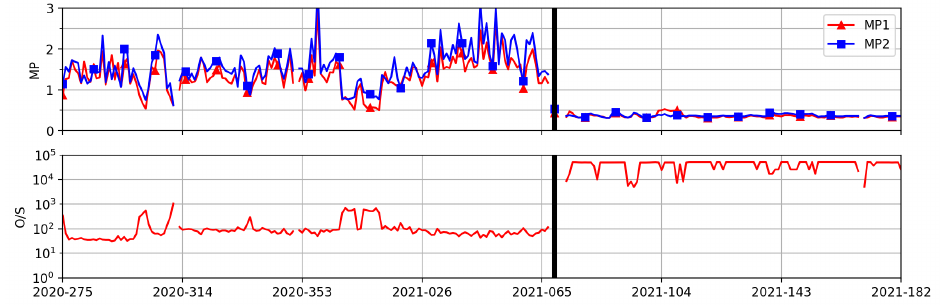
Figure 2. Daily quality check diagnostics of GPS phase observations for the period of interest: on the upper panel, MP1 (red) and MP2 (blue) are multipath combinations for L1 and L2 carrier; on the lower panel, O/S is the ratio between complete observations and the number of